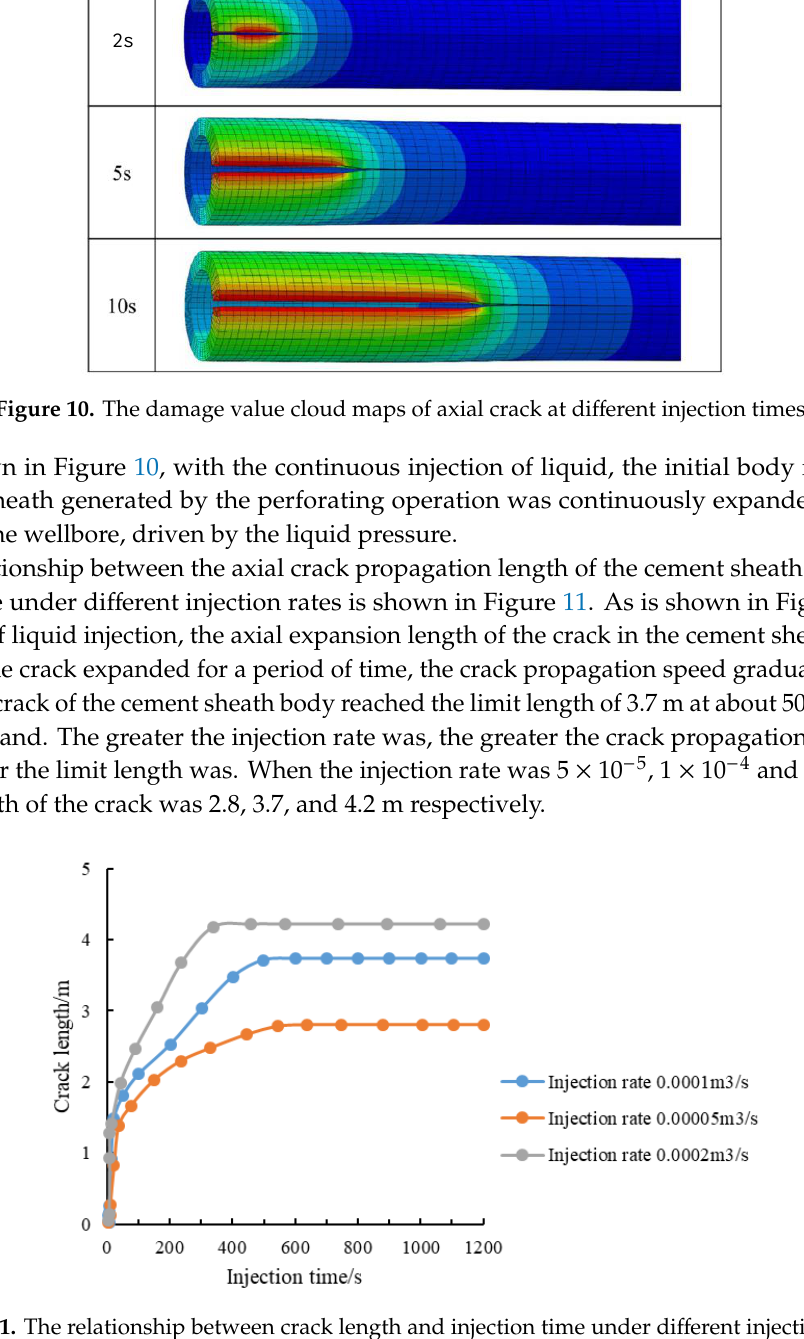
Figure 9. The distribution of damage value along the axial extension path with the distance from the injection point at different times.